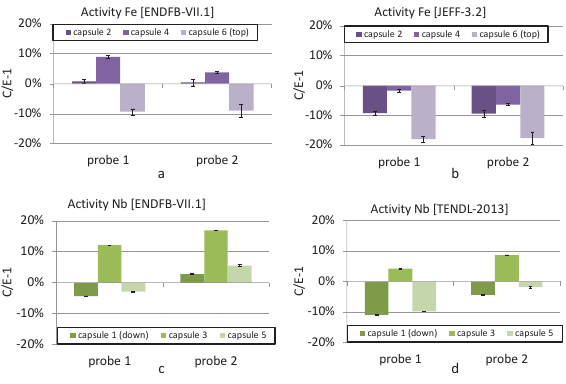
Figure 4. Impact of the dosimetry cross-sections on the PWR C / E results.